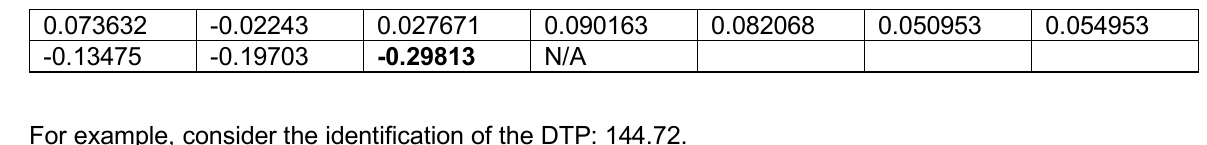
Table 2 : SRC Computation for